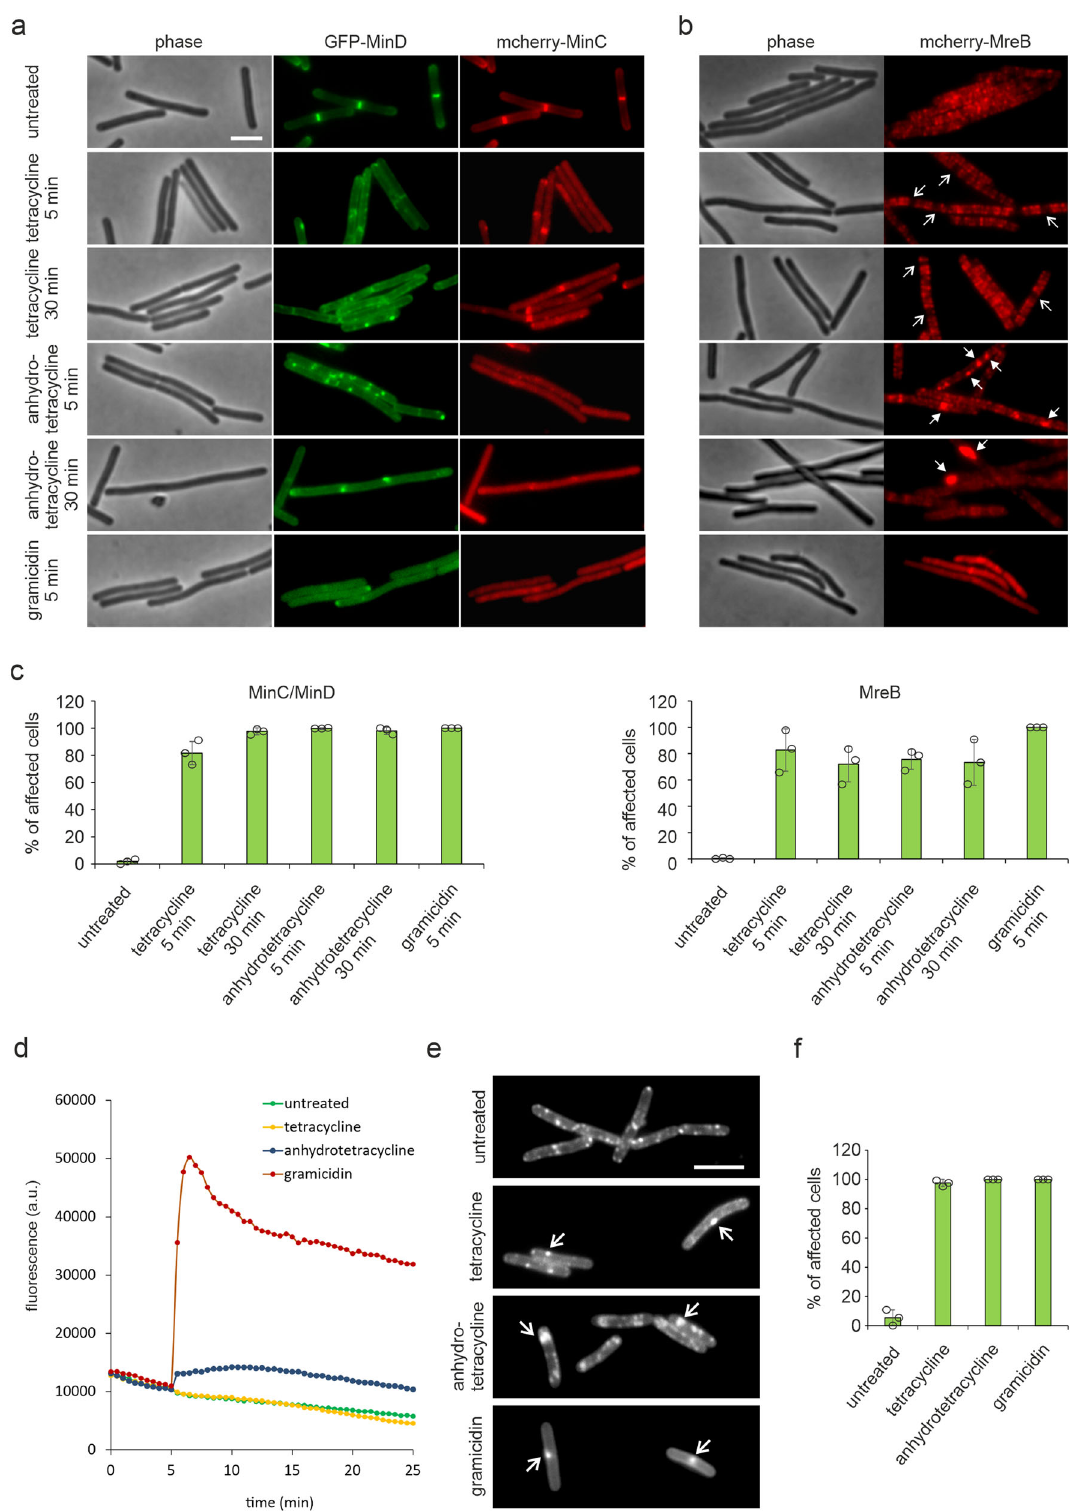
shown in Fig. 5d, no depolarization of the cell membrane was observed, even after 30 min of incubation. Anhydrotetracycline caused partial membrane depolarization. The latter effect was not due to the presence of a subset of cells that had lost their membrane potential (Supplementary Figs. 11 – 13). These results show that tetracycline disturbs the bacterial cell